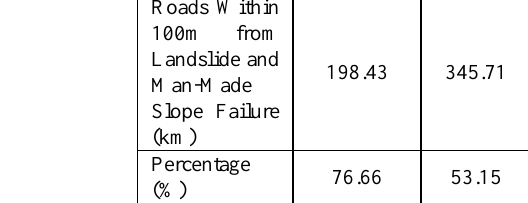
Table 1: Statistics of selected roads within 100 meters distance in Kundasang